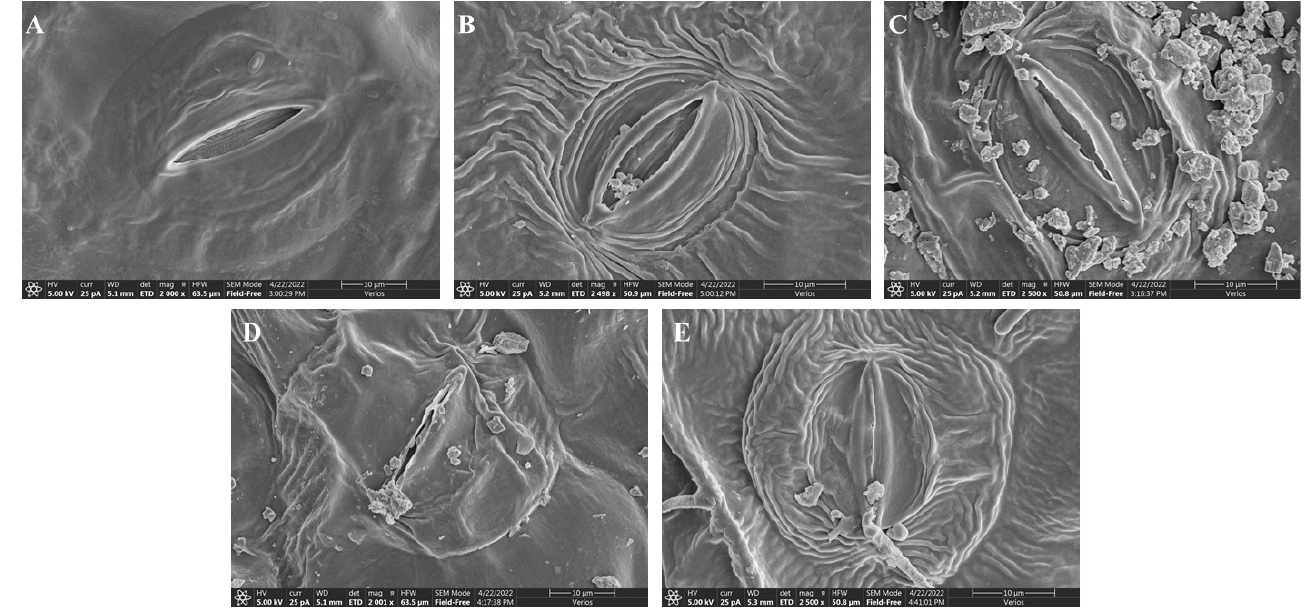
Figure 4. Impact of Cr on the stomatal traits in the leaves of sweet potato. ( A ) Ck, ( B ) 25 µM, ( C ) 50 µM, ( D ) 100 µM, and ( E ) 200 µM. Scale bar is 10 µm and magnification is ( A ) 2000×, ( B ) 2498×, ( C ) 2500×, ( D ) 2001×, and ( E ) 2500×. Table 3. Impact of Cr on the stomatal traits of sweet potato leaf.